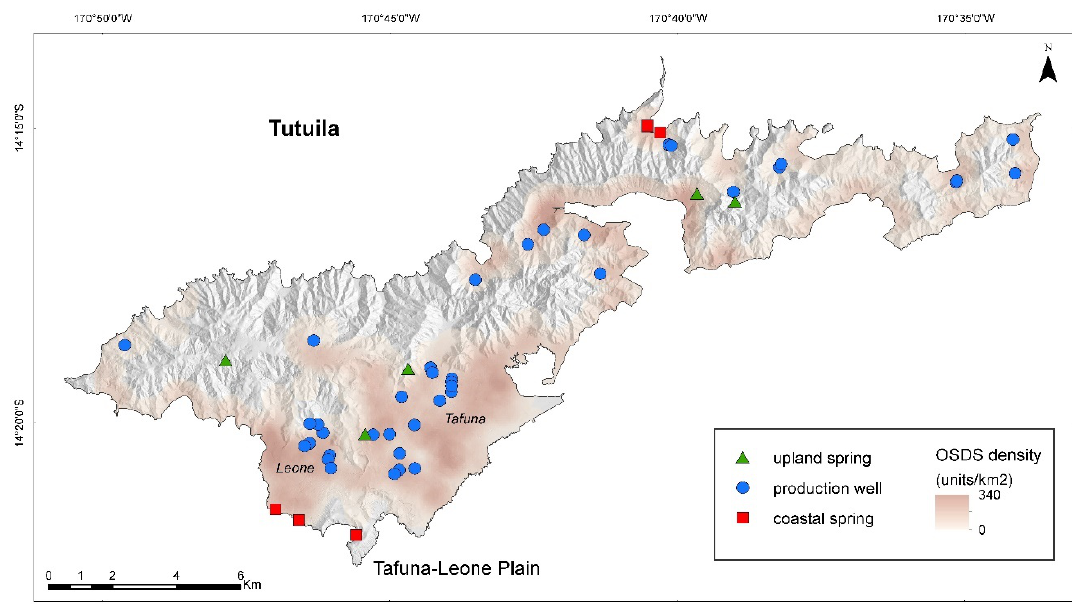
Figure 1. Location map of 50 groundwater sample sites on Tutuila, American Samoa. The density map, based on on-site sewage disposal systems (OSDS) locations from Shuler et al. [2], highlights the areas of urban development in relation to the sampling.